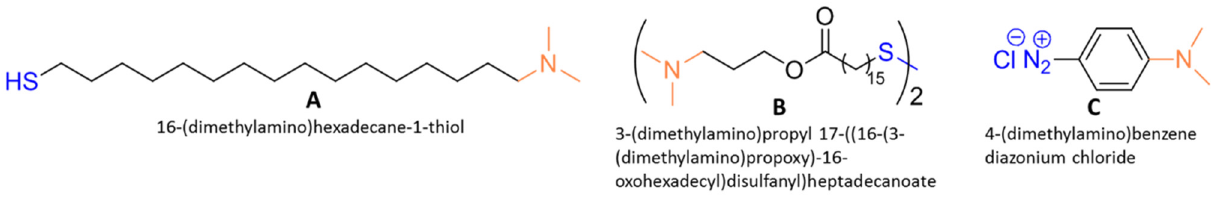
Figure 8. Examples for synergists bearing dimethylamine units (orange) and different coupling groups (blue).